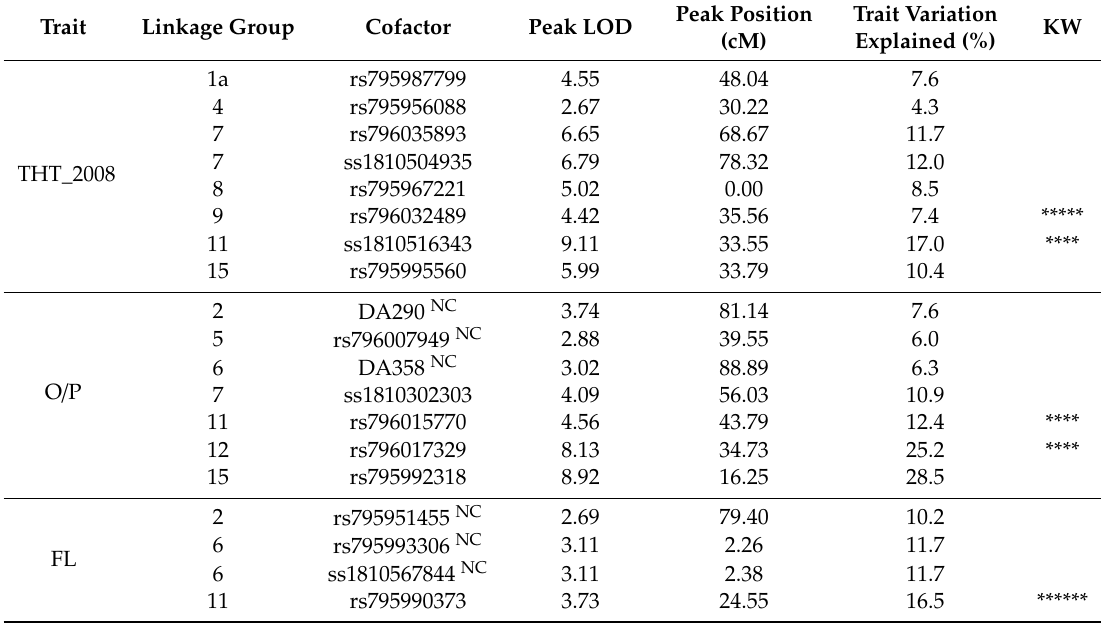
Table 3. Multiple QTL mapping and Kruskal-Wallis test for trunk height recorded in 2008 (THT_2008), frond length (FL) and total oil per palm (O / P) traits in the GM-3341 family.